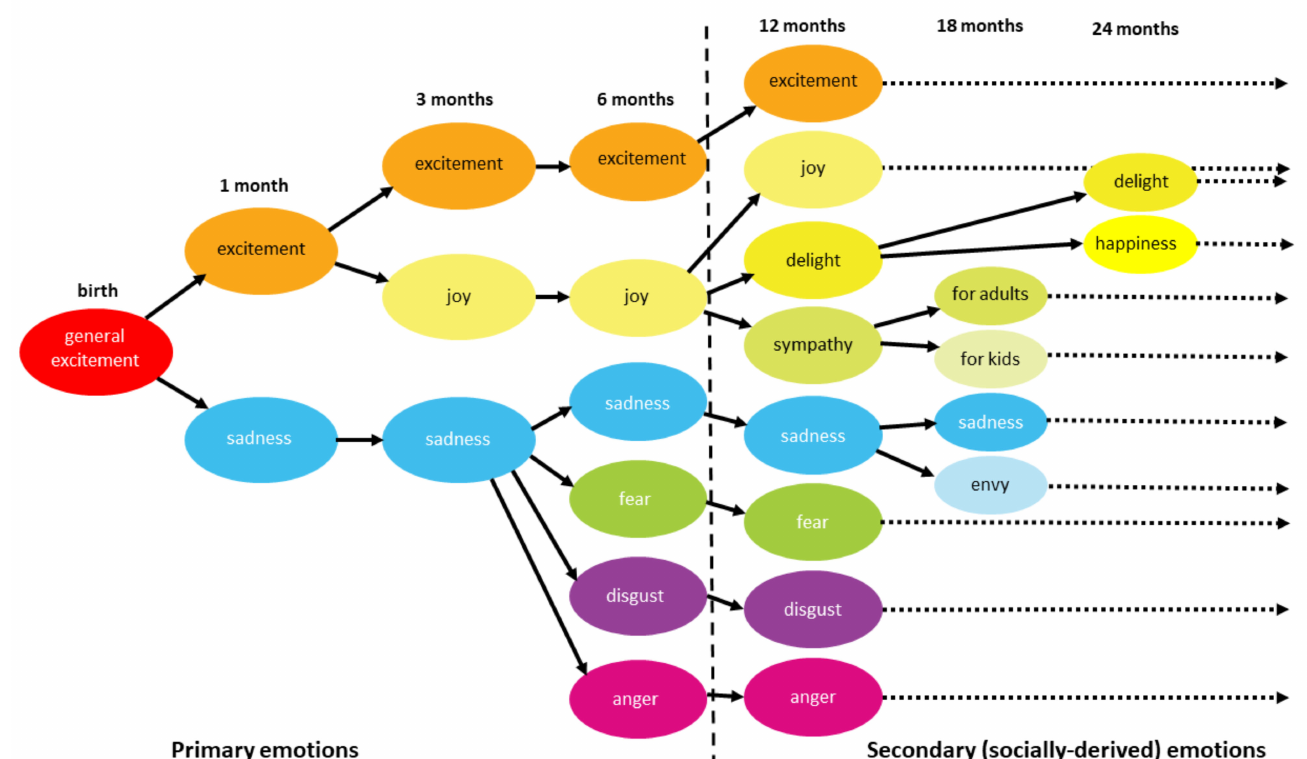
Figure 11. Ontogenesis of individual primary and secondary emotions in the first two years of life . According to Banham Bridges (1932)